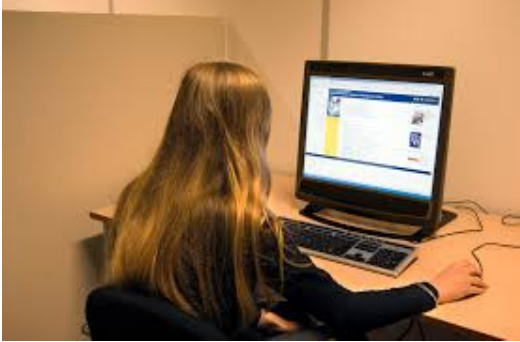
Figure 2. Experiment setting.